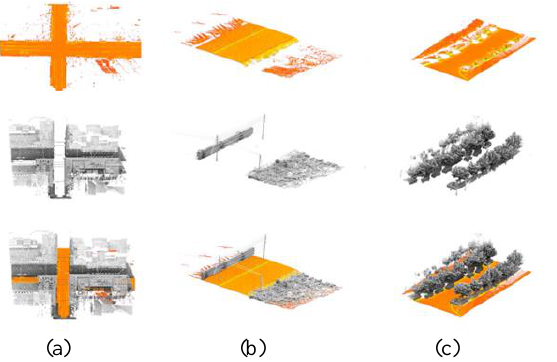
Fig. 9 Sketch maps of the results of terrain extraction using space voxels: (a) MLSD-1, (b) MLSD-2, and (c)